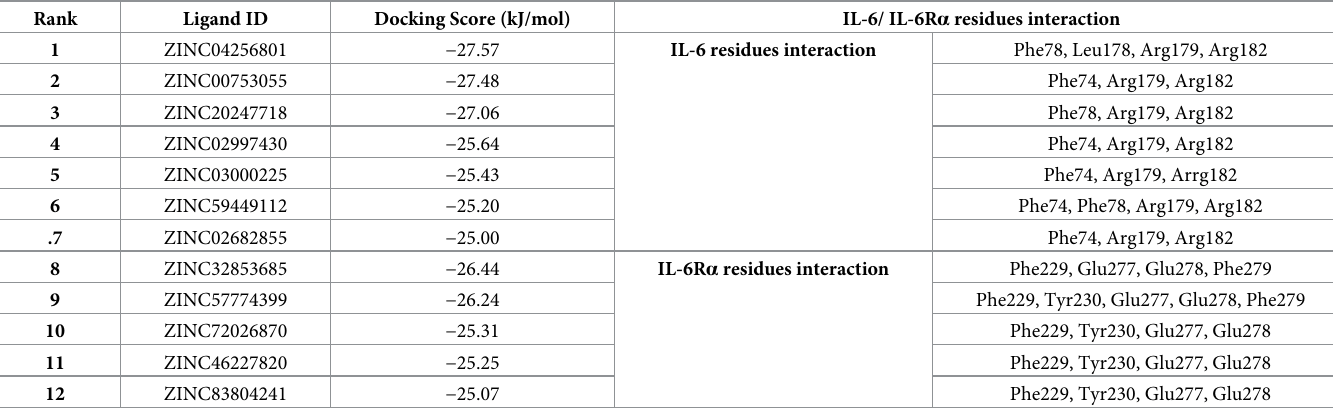
Table 2. The docking scores of top 12 ligands and their interactions with IL-6/IL-6R α